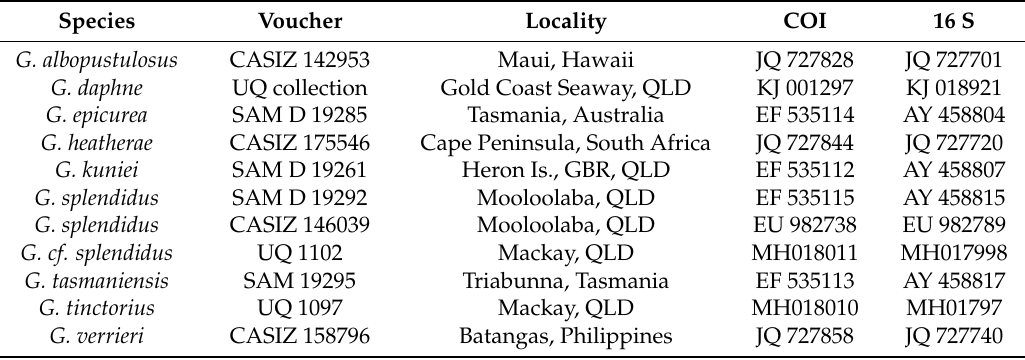
Table 1. Species of Goniobranchus included in the phylogenetic